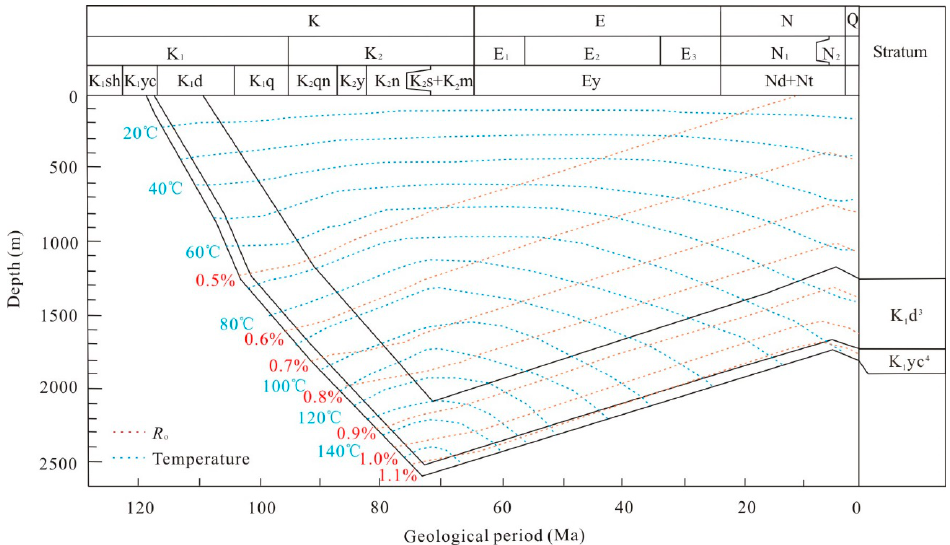
Figure 5. The sedimentary and burial history and thermal history of K 1 yc 4 in the South Shuangcheng Fault Depression.